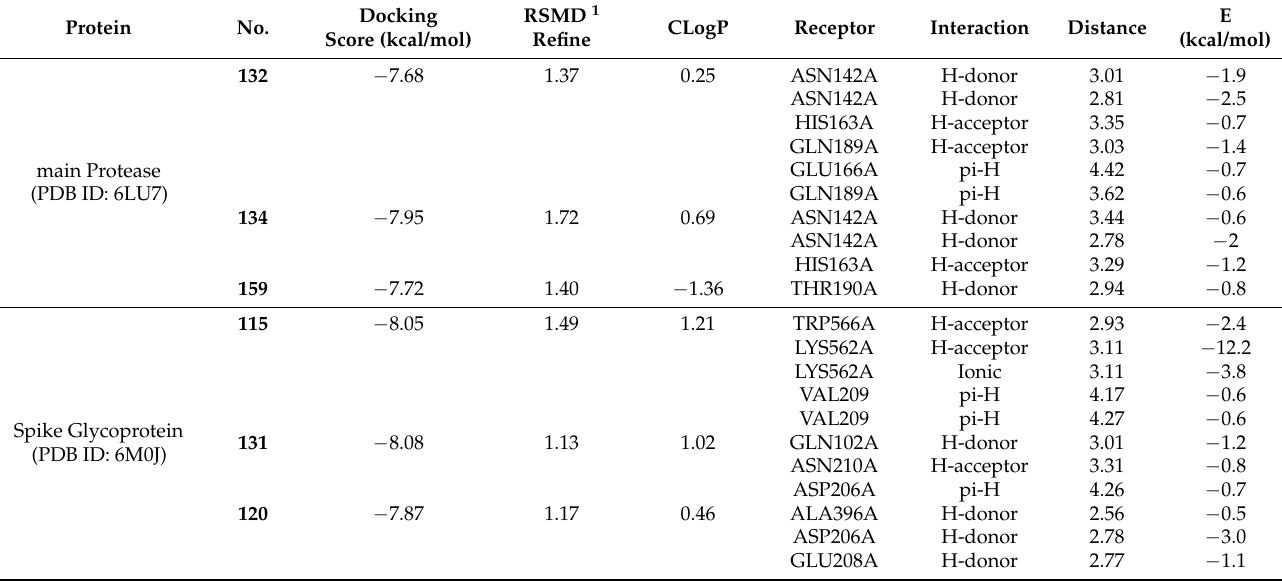
Table 1. Molecular docking results and interactions of the three top scoring compounds of Aloe species with SARS-CoV- 2 proteins.